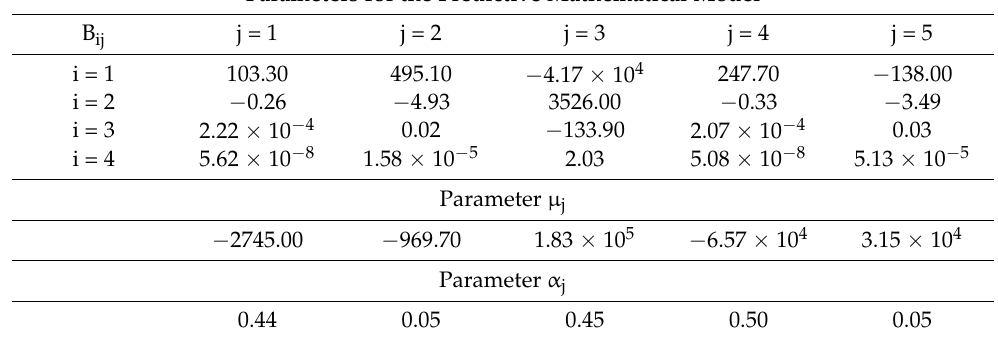
Table 2. Parameters of the predictive mathematical model proposed for determining the price of agave based on: β i1 ( i = 1,2,3,4, ) number of plants available; β i2 ( i = 1,2,3,4 ) production of Tequila; ( i = 1,2,3,4 ) dollar exchange rate; β ( i = 1,2,3,4 ) total export of Tequila; β ( i = 1,2,3,4 ) an- β i3 i4 i5 nual accumulated precipitation; µ j ( j = 1,2,3,4,5 ) unmeasurable uncertainties and weight